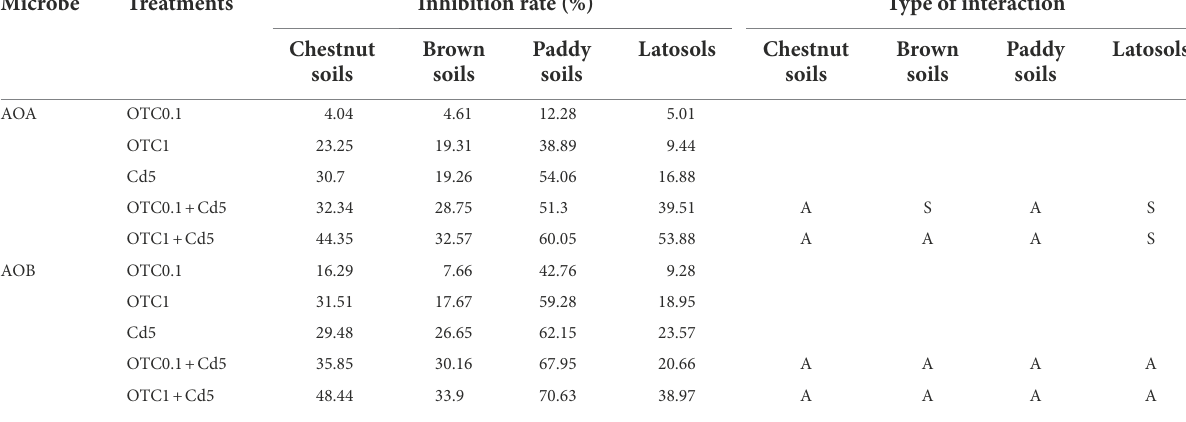
TABLE 4 Interaction types of OTC and Cd on AOA and AOB at day 56. Microbe